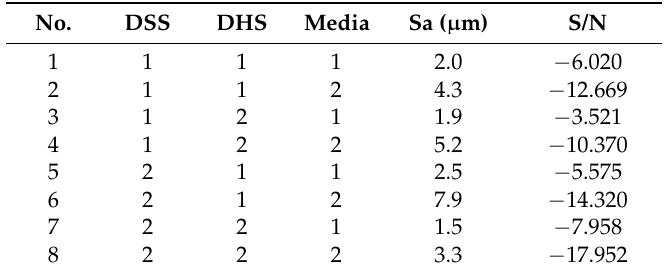
Table 6. Drag finishing process parameters and their levels.